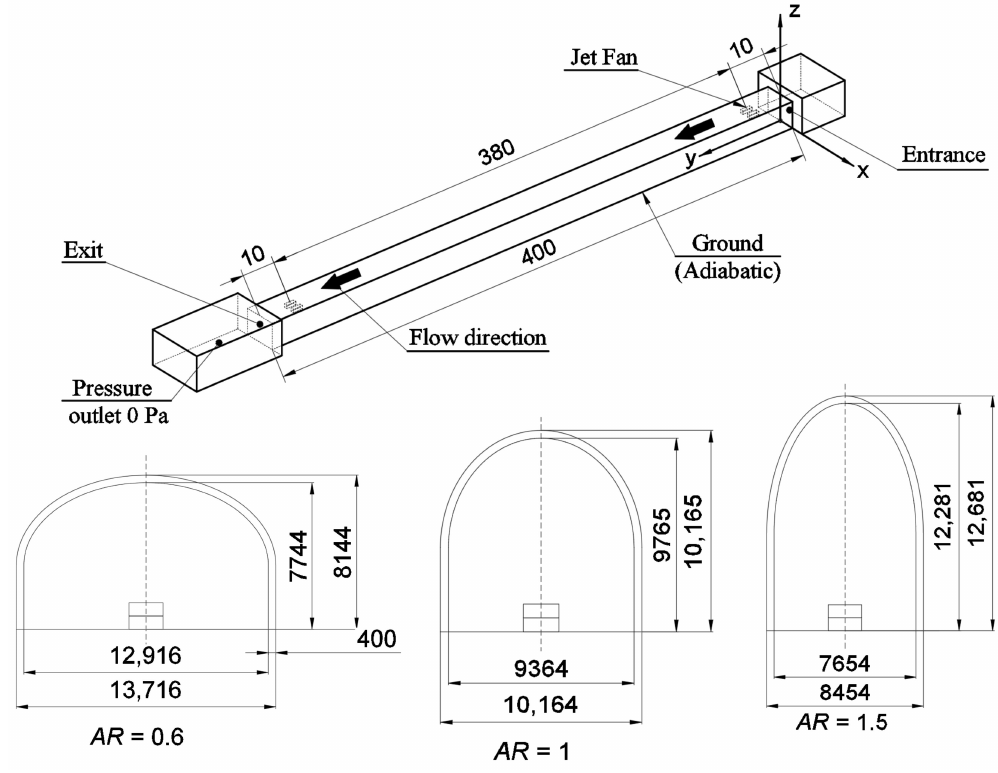
Figure 4. The geometry of the